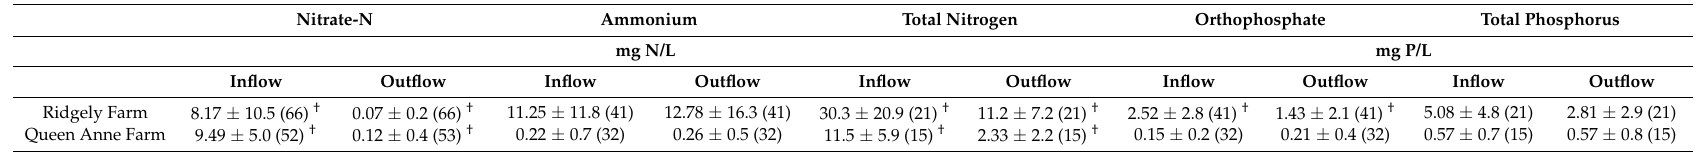
Table 3. Nutrient concentration arithmetic mean ± SD (sample count) for Ridgely and Queen Anne bioreactor inflow and outflow. Nitrate-N Ammonium Total Nitrogen Orthophosphate Total Phosphorus mg N/L mg P/L Inflow Outflow Inflow Outflow Inflow Outflow Inflow Outflow Inflow Outflow Ridgely Farm